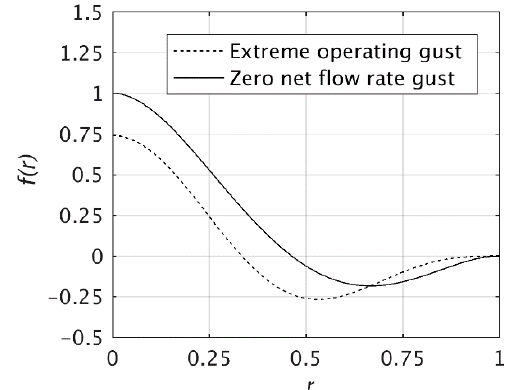
Figure 6. Comparison between the zero net flow rate gust shape function and the “extreme operating gust” from the 61400-IEC standards for wind turbines.